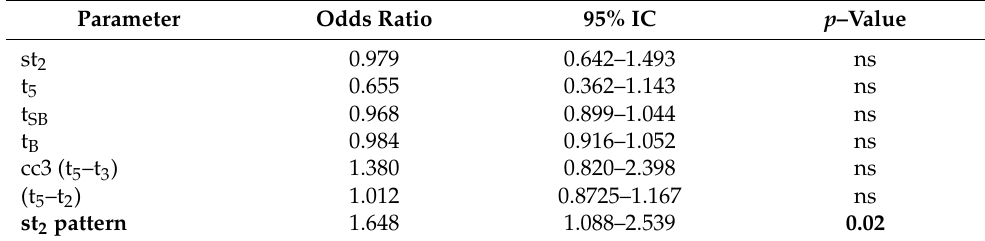
Table 4. Multivariate logistic regression